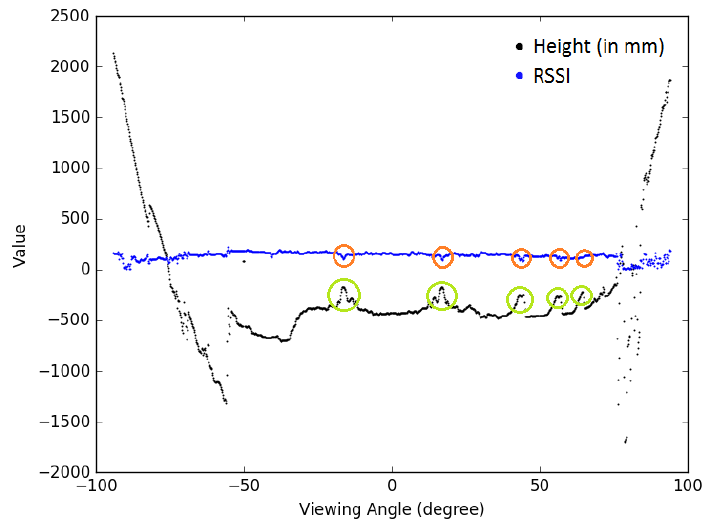
Figure 3. Plot of Height (in mm) and RSSI values of points in one sweep made by the laser scanner. Firstly, a moving average filter of size 3 measurements (equivalent to a width of 0.5 degrees) was used to reduce noise in the data. A moving window of size 5 measurements (equivalent to